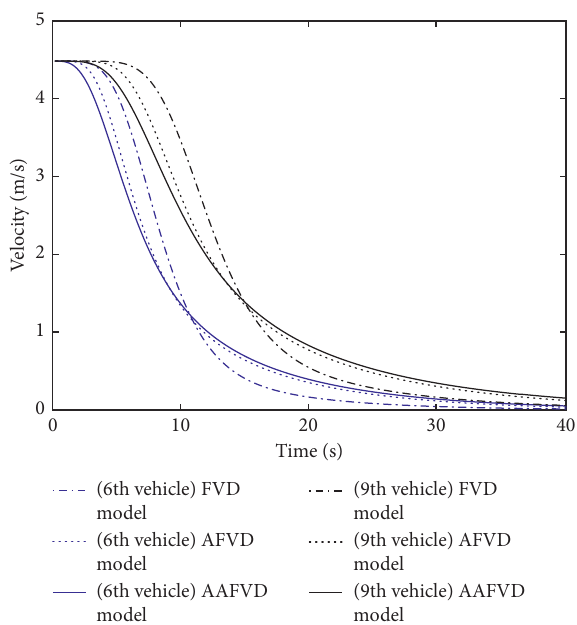
Figure 7: Comparison of two vehicles’ velocity during the arrival process simulated by the FVD, AFVD, and AAFVD